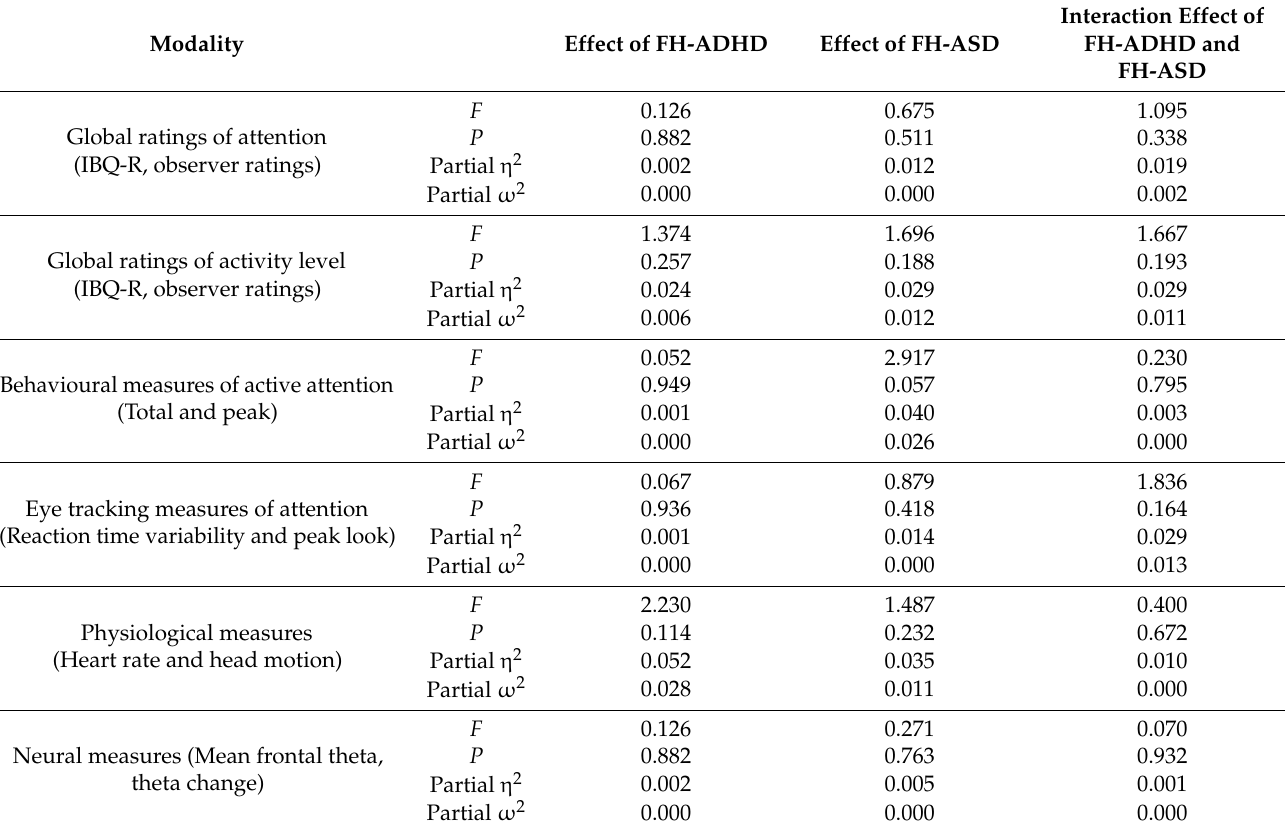
Table 2. Effect of Family History of ADHD and/or ASD on infant activity level and